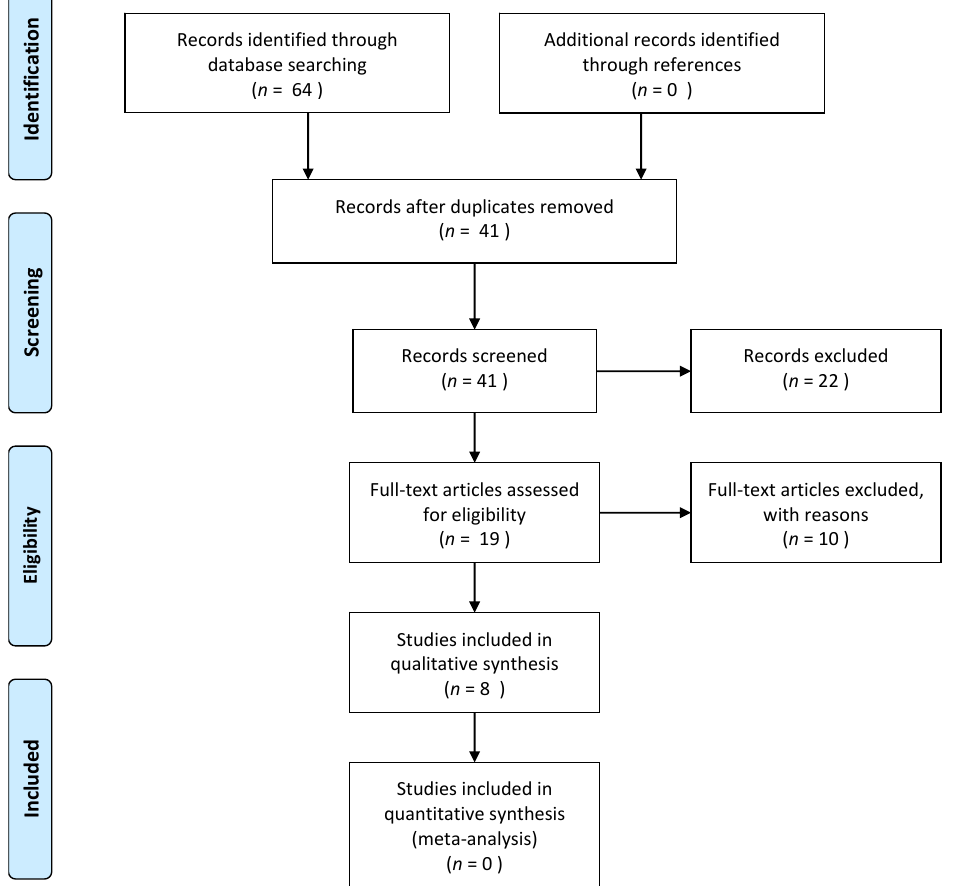
Figure 2. PRISMA flow diagram depicting the flow of information through the different phases of the systematic review.